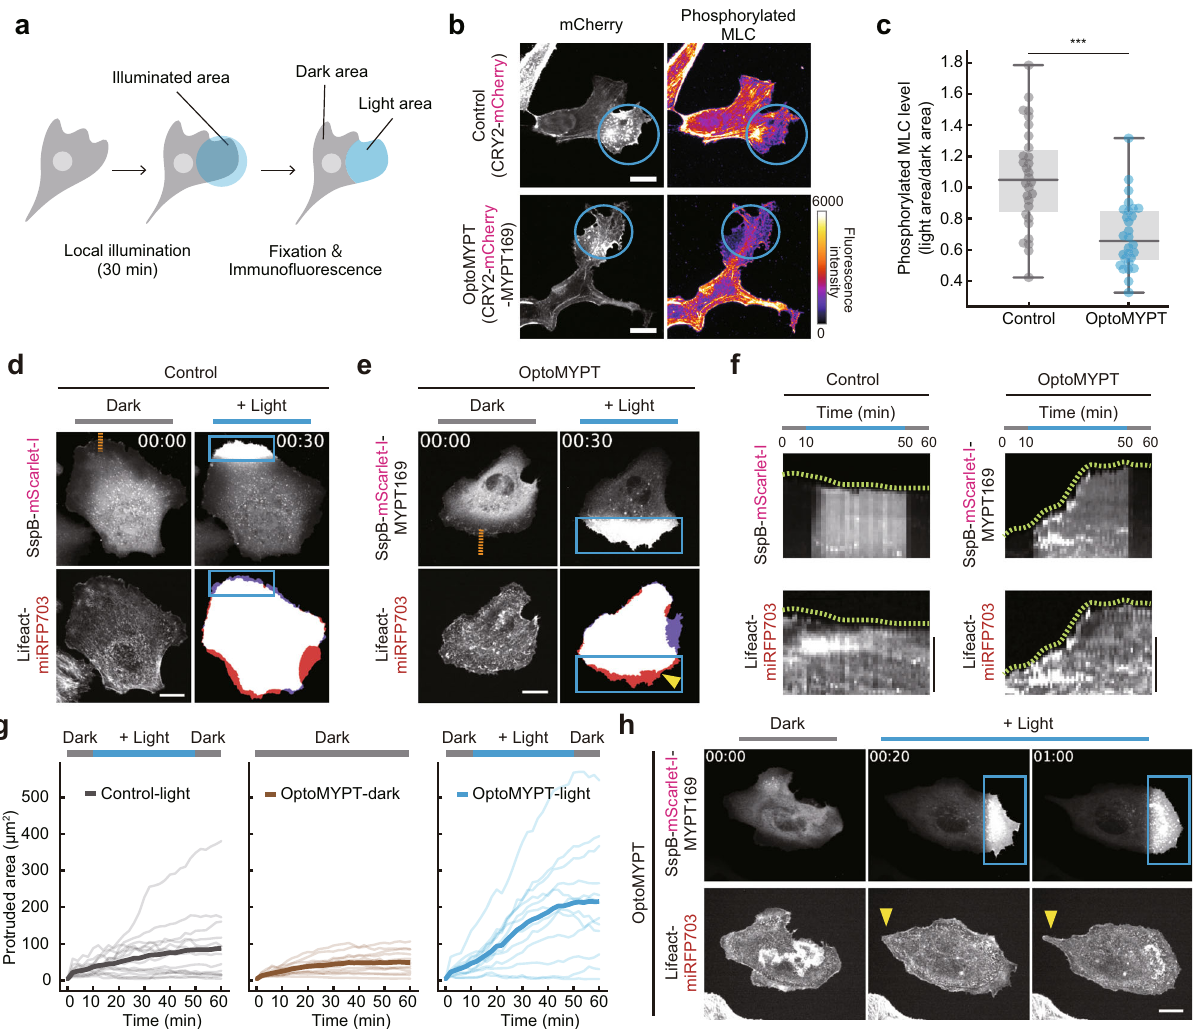
Fig. 2 Light-induced dephosphorylation of MLC and membrane protrusion by OptoMYPT. a Schematic illustration of an experimental procedure to quantify phosphorylated MLC levels. The blue light was locally focused on the lamellipodial area in each cell, followed by fi xation and immunostaining. b Immuno fl uorescence analysis of MLC phosphorylation after blue-light illumination. The upper and lower images show MDCK cells expressing CRY2- mCherry and CRY2-mCherry-MYPT169, respectively. CIBN-EGFP-KRasCT was also expressed as a localizer in both experiments. The blue circular region was illuminated with 500 msec of blue light at 2 min intervals for 30 min. Scale bar, 10 μ m. c The phosphorylated MLC level was quanti fi ed by dividing the mean fl uorescence intensity of the light area by that of the dark area in panel a , and shown as a box plot. n = 30 and 28 cells for the control and OptoMYPT, respectively. *** p = 8.4 × 10 − 8 (two-sided Brunner – Munzel test) 74 . d , e Simultaneous visualization of SspB-mScarlet-I ( d ) or SspB-mScarlet-I- MYPT169 ( e ) with F-actin (Lifeact-miRFP703) in MDCK cells. The blue rectangular regions were illuminated with 500 msec blue light every 20 sec. The right bottom image shows a binary image reconstructed from Lifeact-miRFP703 images; red and purple areas represent protruding and retracting areas, respectively. The yellow arrowheads depict membrane protrusion. Scale bar, 20 μ m. f Kymographs were drawn along the orange dashed lines in panels a and b . Green dashed lines show cell boundaries. Scale bar, 5 μ m. g Quanti fi cation of the local protruding areas under the indicated conditions. The total protruded area was calculated by subtracting the cell area in the illuminated region at t = 0 from that at each time point. Local blue light was illuminated from 10 to 50 min. The thin and bold lines indicate the individual and averaged data, respectively. n = 15, 13, and 12 cells for Control-light (blue light illumination), OptoMYPT-dark (dark condition), OptoMYPT-light (blue light illumination), respectively. h Representative images of the induction of membrane retraction (yellow arrowhead) on the opposite side of the blue-light illuminated area. The blue rectangular regions were locally illuminated with 500 msec blue light every 20 s. Scale bar, 20 μ